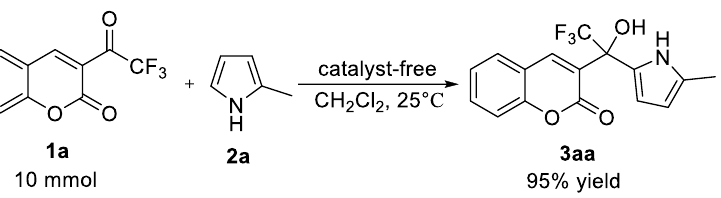
Figure 3. X-ray crystal structure of compound 3fa (CCDC 2167896) . The in vitro antifungal activity of target compounds 3aa-3hd against six representa- tive phytopathogens is summarized in Table 3. Triadimefon was used as a positive control at a concentration of 10 ug/mL. In general, the title compounds exhibited a certain degree of fungicidal activity at a concentration of 500 ug/mL. Among them, compounds 3ad , 3bd, and 3cd showed over 90% inhibition against F. graminearum (from corn). Compounds 3ad , 3bd , 3gd, and 3hd showed over 80% inhibition against F. oxysporum. Compounds 3ad and 3bd showed over 80% inhibition against F. graminearum (from wheat). In partic- ular, 3ad , 3gd, and 3hd exhibited excellent activity (>98%) against R. solani Kuhn. Com- pounds 3ac , 3ad , 3bd , 3gd, and 3hd exhibited higher antifungal activity (> 80%) against P. parasitica var nicotianae. Furthermore, it was also worth noting that 3ad , 3gd, and 3hd exhibited broad-spectrum antifungal activity and could be considered as new fungicidal leads for further optimization. The in vitro fungicidal activity of the title compounds against six phytopathogens showed that the substituents have a great impact on the activity. Overall, the fungicidal activity of 3-ethyl-2,4-dimethyl-1H-pyrrole derivatives ( 3ad , 3bd , 3cd , 3gd, and 3hd ) showed generally higher inhibition against the tested fungi than other substituted pyrrole derivatives.